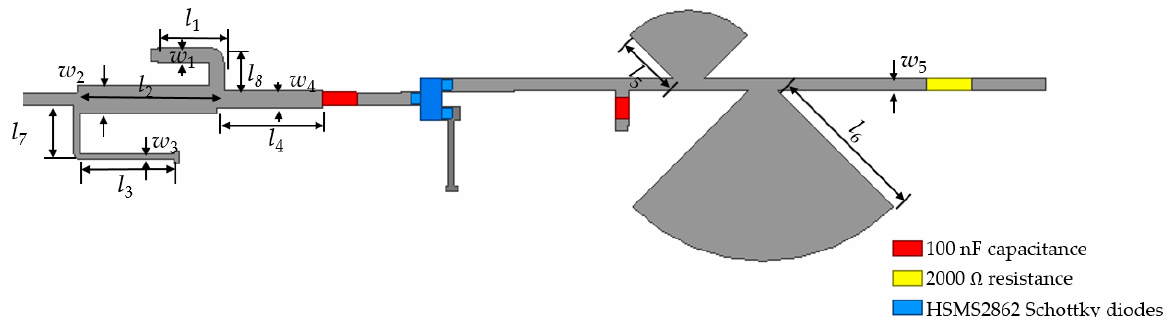
Figure 11. Configuration of the proposed rectifier circuit: l 1 = 3.5 mm; l 2 = 8.7 mm; l 3 = 6.3 mm; l 4 = 6.6 mm; l 5 = 5.1 mm; l 6 = 12.9 mm; l 7 = 5.1 mm; l 8 = 1.5 mm; w 1 = 1 mm; w 2 = 1.8 mm; w 3 = 0.4 mm; w 4 = 1.2 mm; w 5 = 0.8 mm.